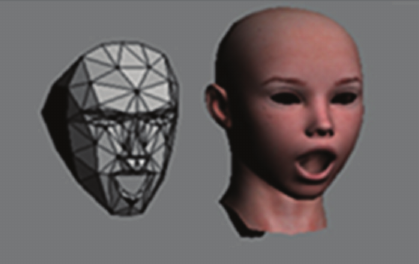
Figure 3: AU1—Jaw Lowerer Each AU is expressed as a numeric weight varying between − 1 and +1. This figure has been extracted from the Face Tracking SDK Kinect for Windows available at